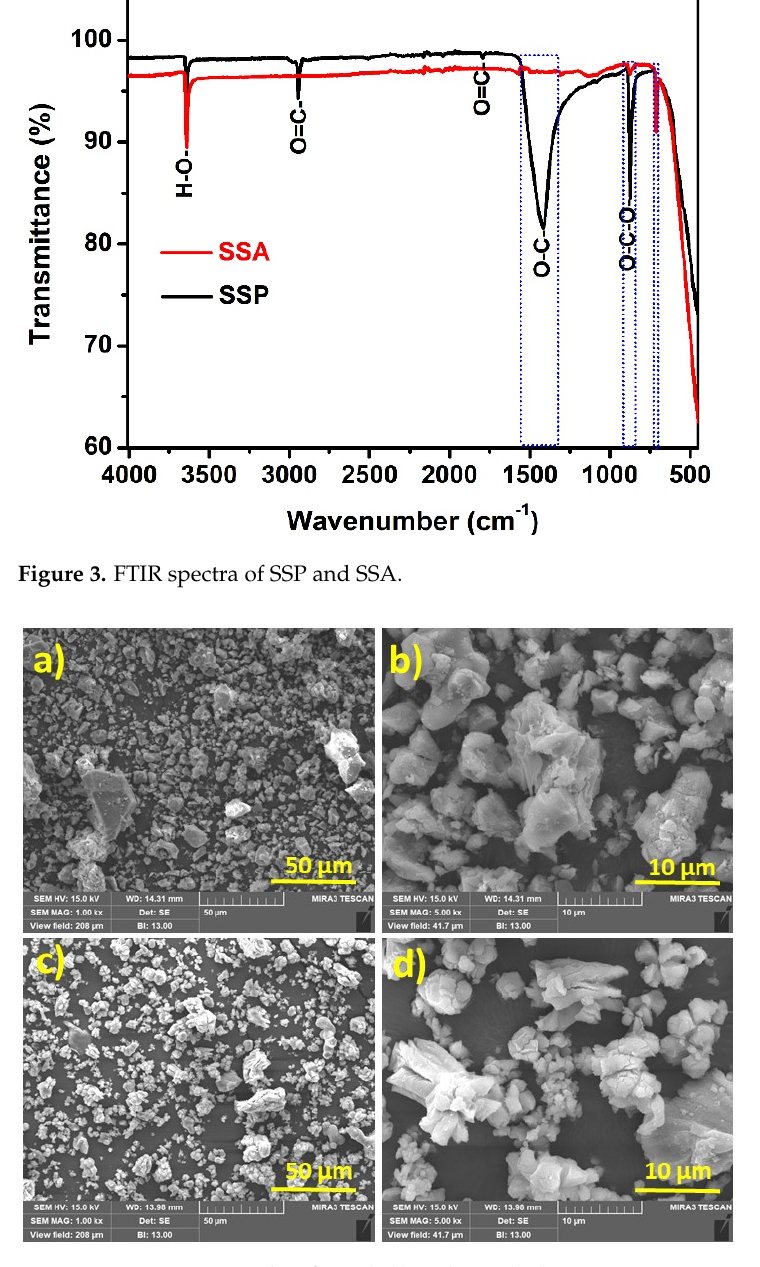
Figure 4 . SEM micrographs of SSP ( a , b ) and SSA ( c , d ). Figure 4. SEM micrographs of SSP ( a , b ) and SSA ( c , d